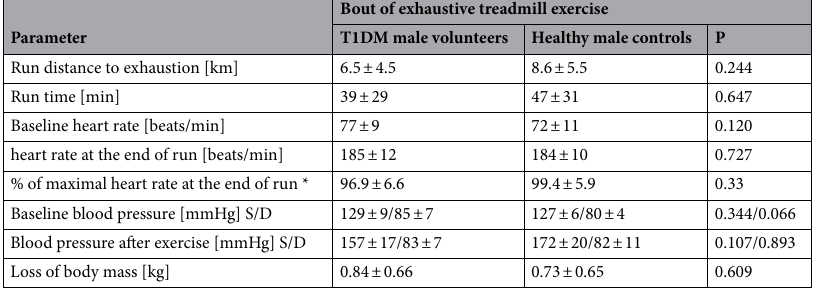
Bout of exhaustive treadmill exercise T1DM male volunteers Healthy male controls P